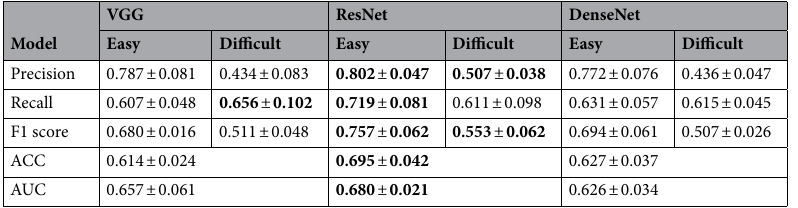
Table 2. Performance for binary classification of cannulation difficulty. Bold fonts represent the best performance among the methods. AUC area under the receiver operating characteristic curve, ACC accuracy.